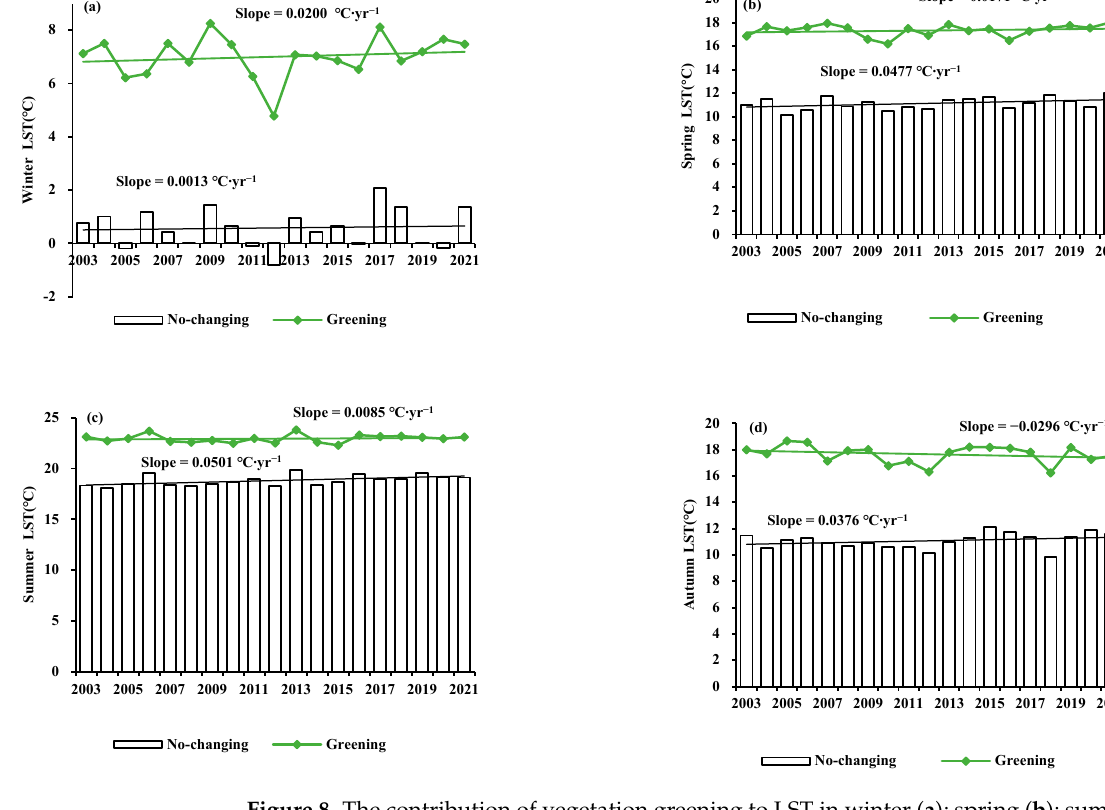
Figure 8. The contribution of vegetation greening to LST in winter ( a ); spring ( b ); summer ( c ); and autumn ( d ) from 2003 to 2021.